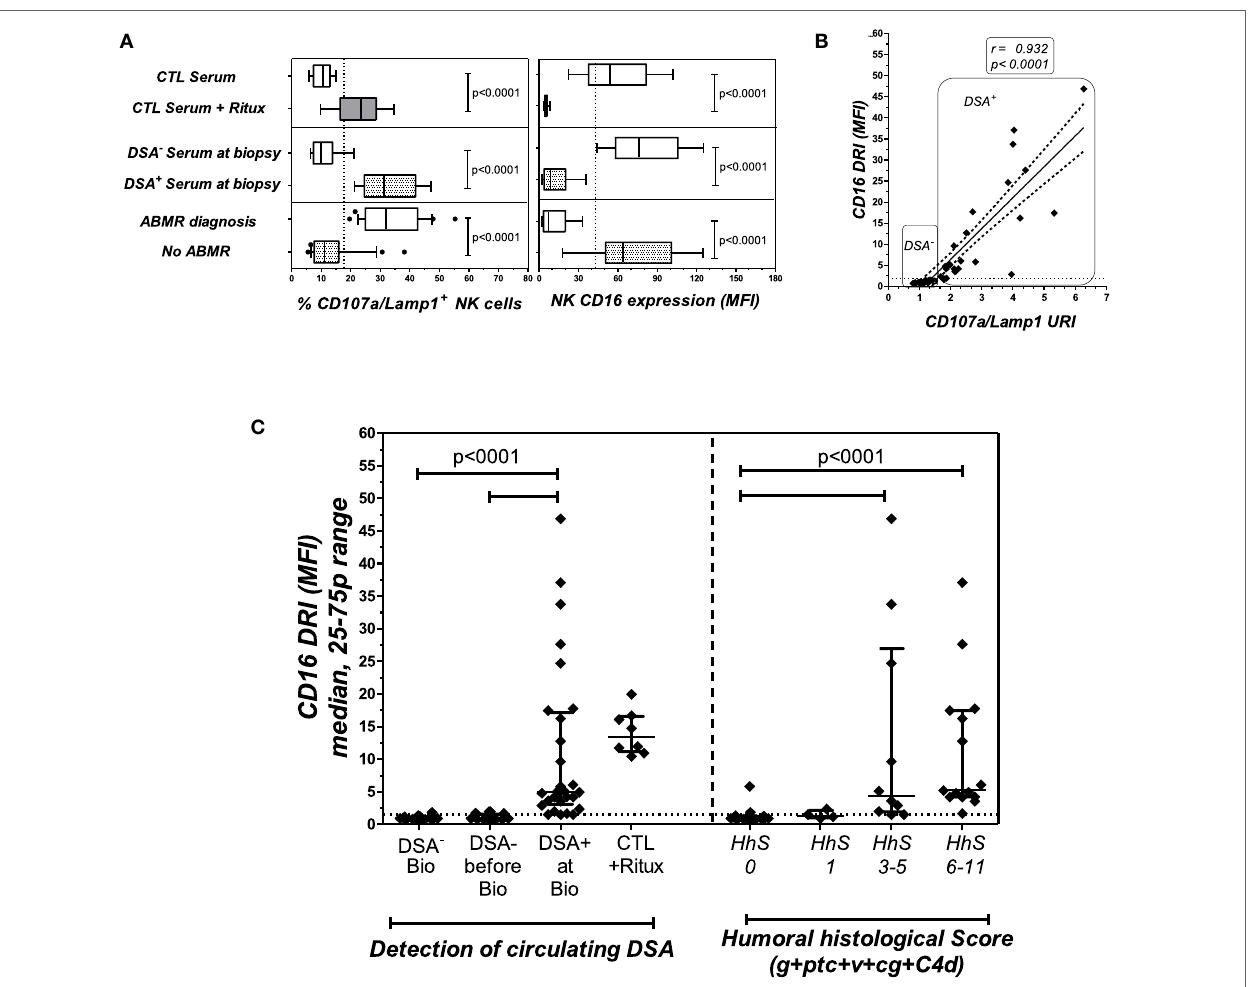
FigUre 4 | The nK-chaT evaluation of Dsa reactivity toward B cell targets in sera collected at the time of transplant biopsy . (a) The modulation of CD16 (MFI) and CD107a/Lamp1 on NK effector cells exposed to serum-coated B cell targets was analyzed. Forty-three sera samples were collected from 40 KTRs at the time of biopsy and grouped according to the detection (DSA + , n = 25 sera obtained in 22 patients) or absence (DSA − , n = 18 patients) of B cell-specific circulating DSAs (the DSA specificities and MFI are detailed in Table 4 ) or to ABMR diagnosis. Rituximab was added to DSA − serum and used as a positive control for the test. (B) Correlation of CD16DRI and CD107a/Lamp1URI scores for sera samples collected at the time of biopsy. (c) At the time of transplant biopsy (Bio), higher CD16DRI scores were associated with the presence of circulating DSAs (left panel) and humoral histological scores greater than 3 (g + ptc + v + cg + C4d of Banff’s classification, right panel). The CD16RI scores of DSA − serum from the same sensitized KTR, obtained prior to the detection of dn DSAs (before Bio), were also evaluated in reference to DSA + serum sampled at the time of